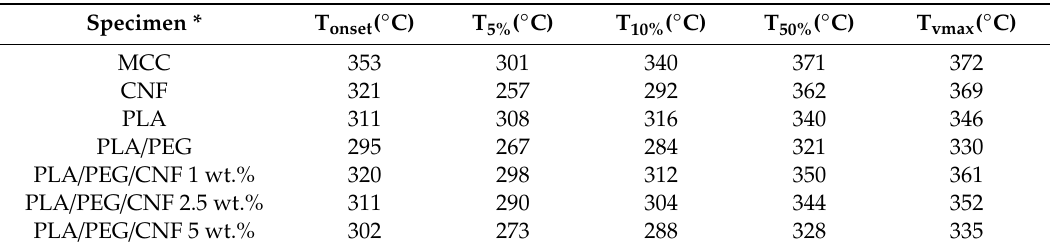
Table 1. Weight loss temperature of MCC, CNF, PLA, PLA / PEG, and PLA / PEG / CNF composites. Specimen * T onset ( ◦ C) T 5% ( ◦ C) T 10% ( ◦ C) T 50% ( ◦ C) T vmax ( ◦ C) MCC 353 301 340 371 372 CNF 321 257 292 362 369 PLA 311 308 316 340 346 PLA / PEG 295 267 284 321 330 PLA / PEG / CNF 1 wt.% 320 298 312 350 361 PLA / PEG / CNF 2.5 wt.% 311 290 304 344 352 PLA / PEG / CNF 5 wt.% 302 273 288 328